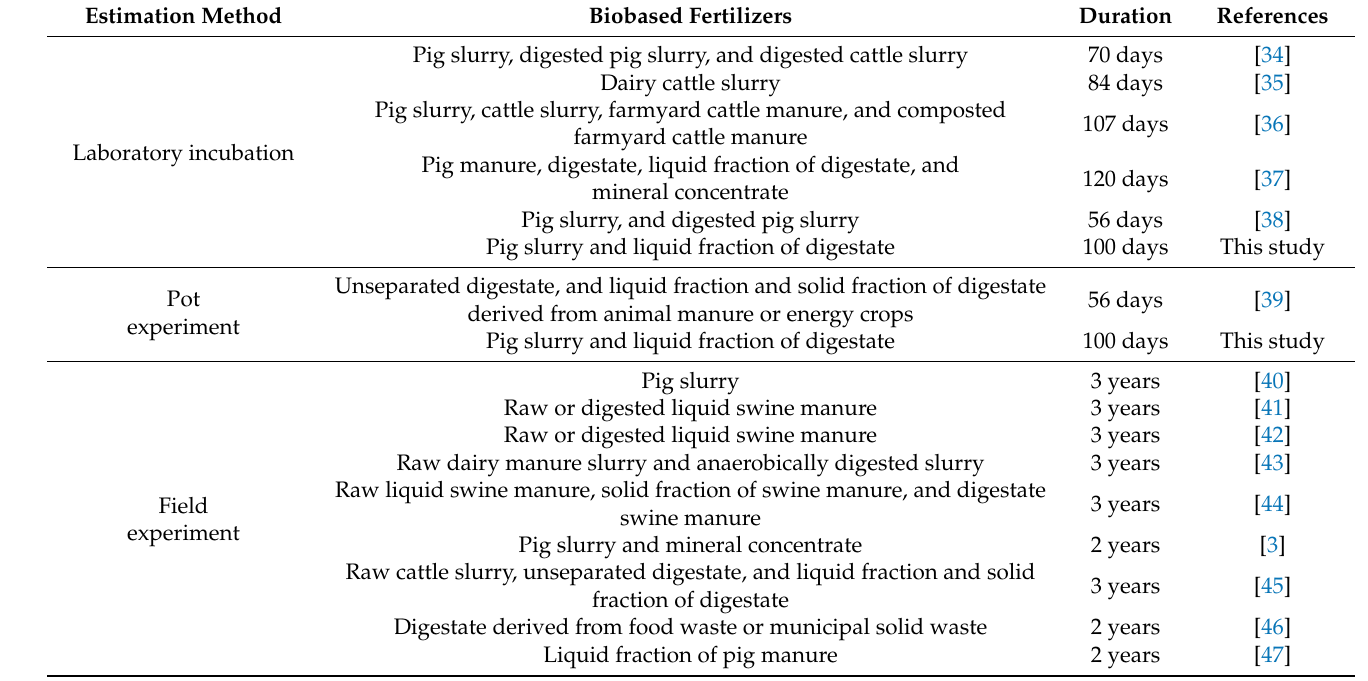
Figure 6. Regression of the mean concentrations of plant-available N (mg kg − 1 DW) in incubation and maize-growing pot. The linear line in red indicates the expected correlation while the linear line in blue indicates the actual correlation. Control = no N fertilizer, CAN = calcium ammonium nitrate, PS = pig slurry, LFD = liquid fraction of digestate. Table 3. Literature data source for Figure 7 referring to the estimation of the N value of biobased fertilizer via laboratory incubations and plant experiments (field or pot).